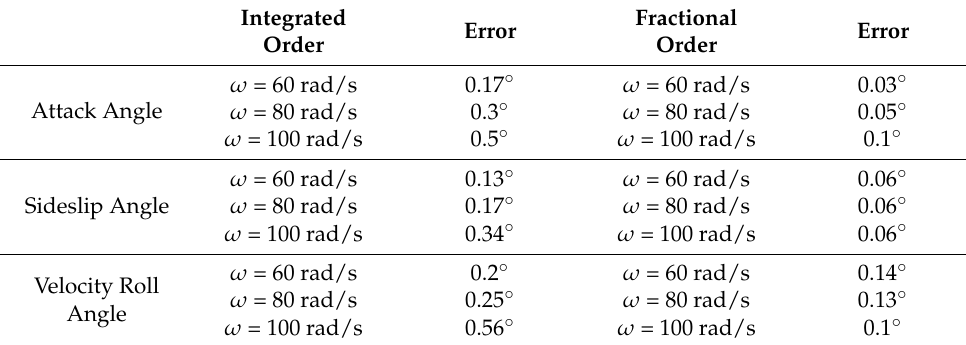
Table 4. Maximum Error of Alpha.